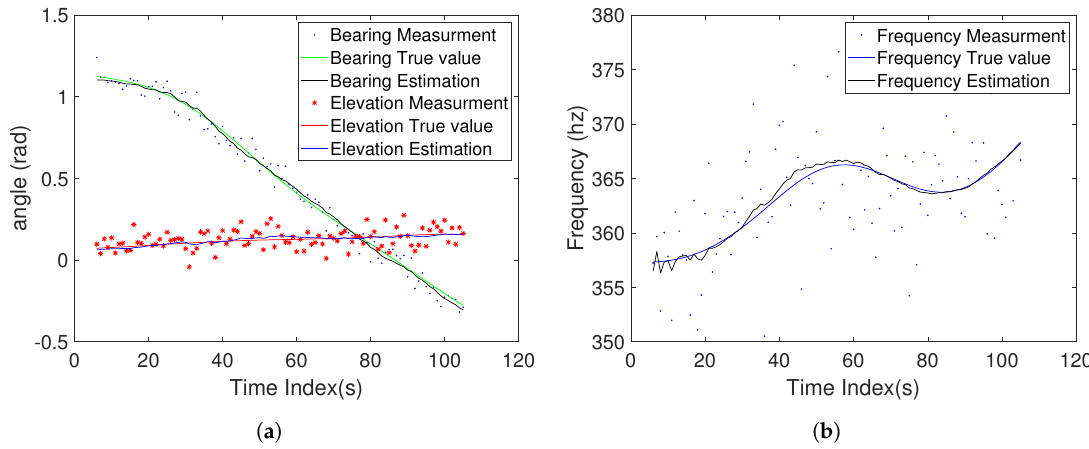
Figure 9. ( a ) The true angle, the angle measurement and estimated angle for GH-IUKF; ( b ) the true frequency, the frequency measurement and estimated frequency for GH-IUKF.